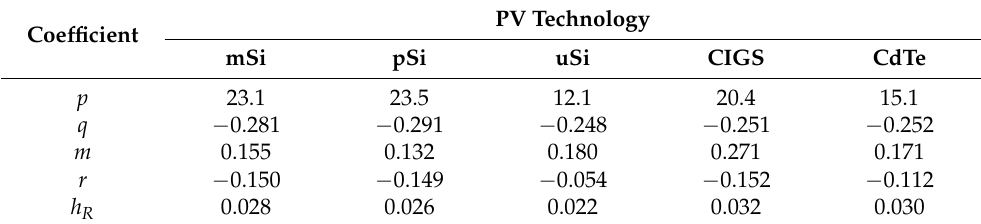
Table 1. Values of the empirical coefficients used in the PV panel modelling [86].